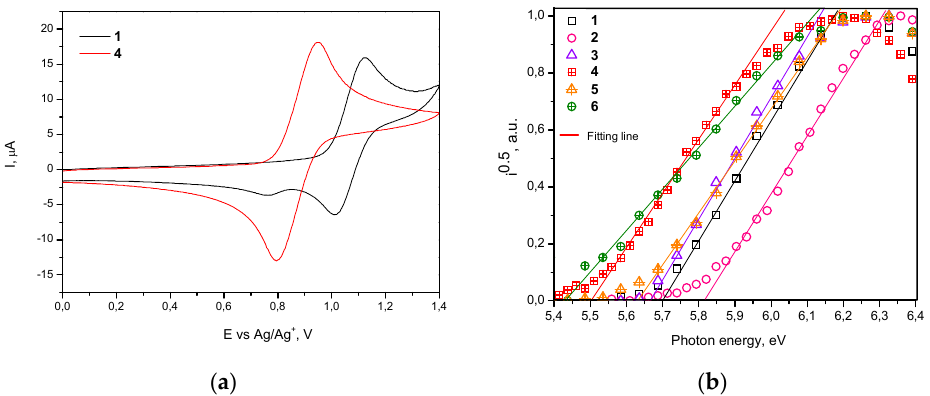
Figure 3. ( a ) First cyclic voltammetry (CV) cycle curves of dilute solutions of compounds 1 and 4 in dichloromethane (room temperature) recorded at sweep rate of 0.1 V/s and ( b ) photoelectron emission spectra of solid films of compounds 1 – 6